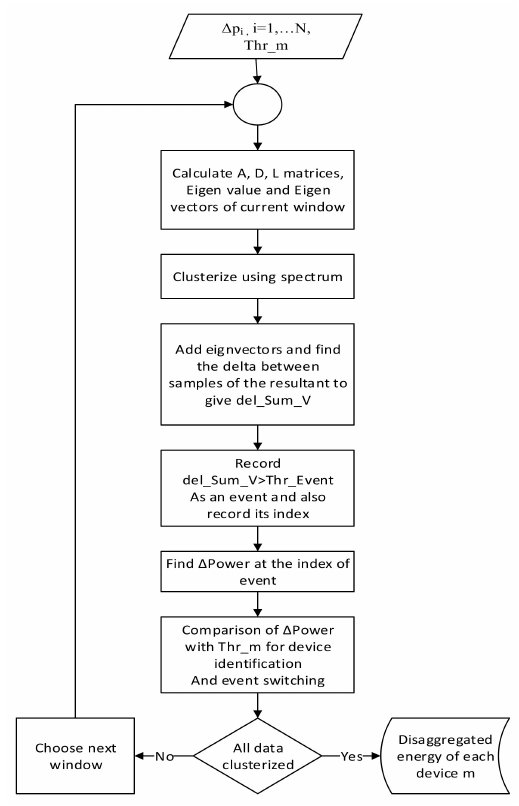
Figure 5. Flowchart of SC-EV